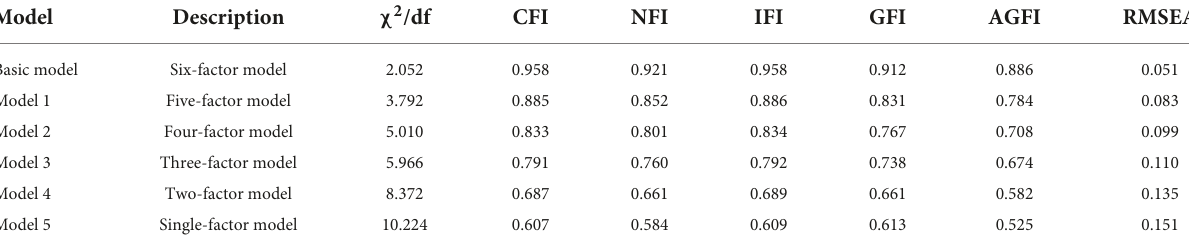
TABLE 2 Confirmatory factor analysis results ( n =